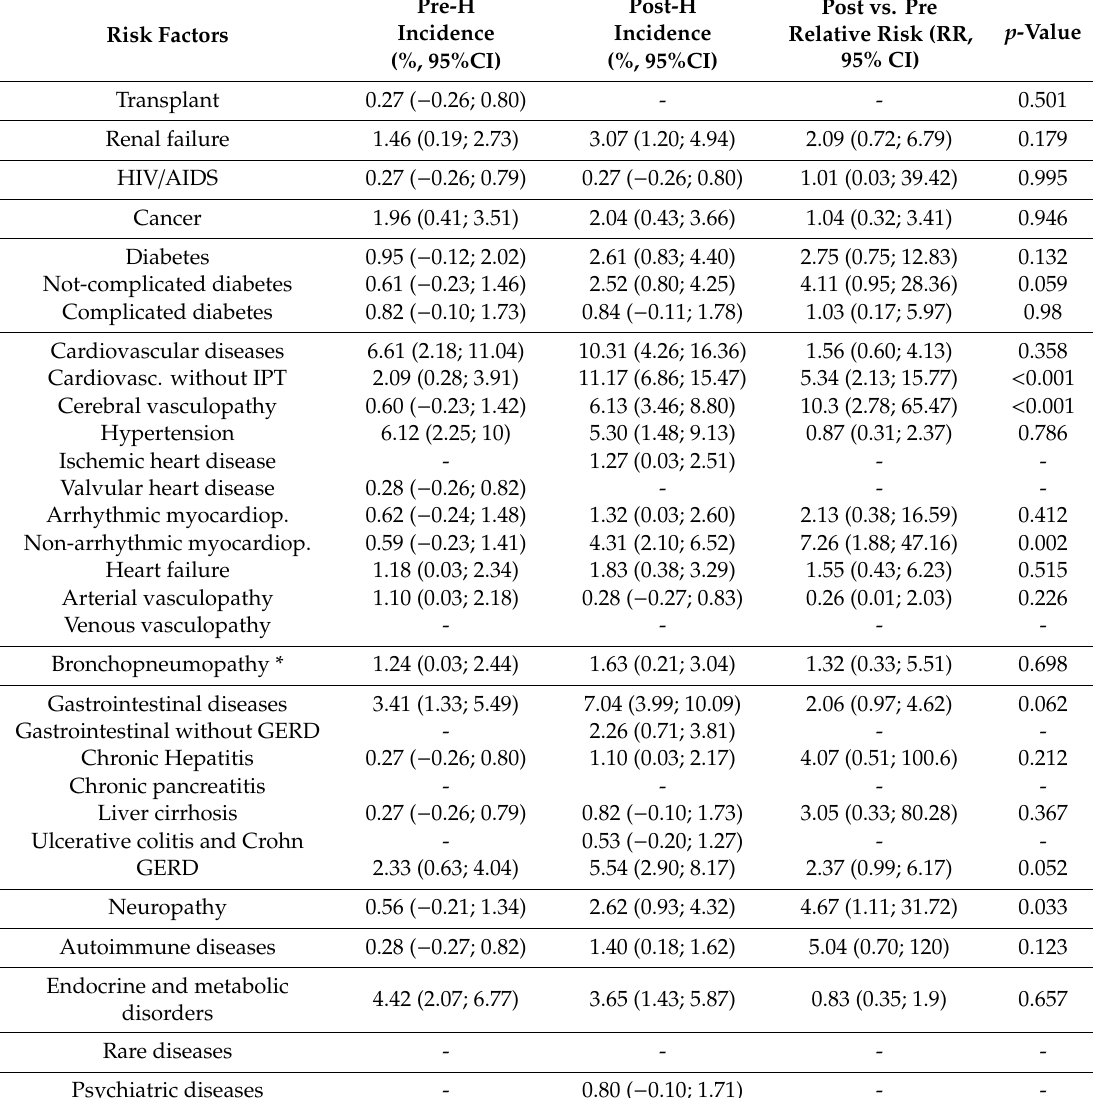
Table 3. Cumulative incidence rate of chronic diseases before and after hospitalization period in the HZ